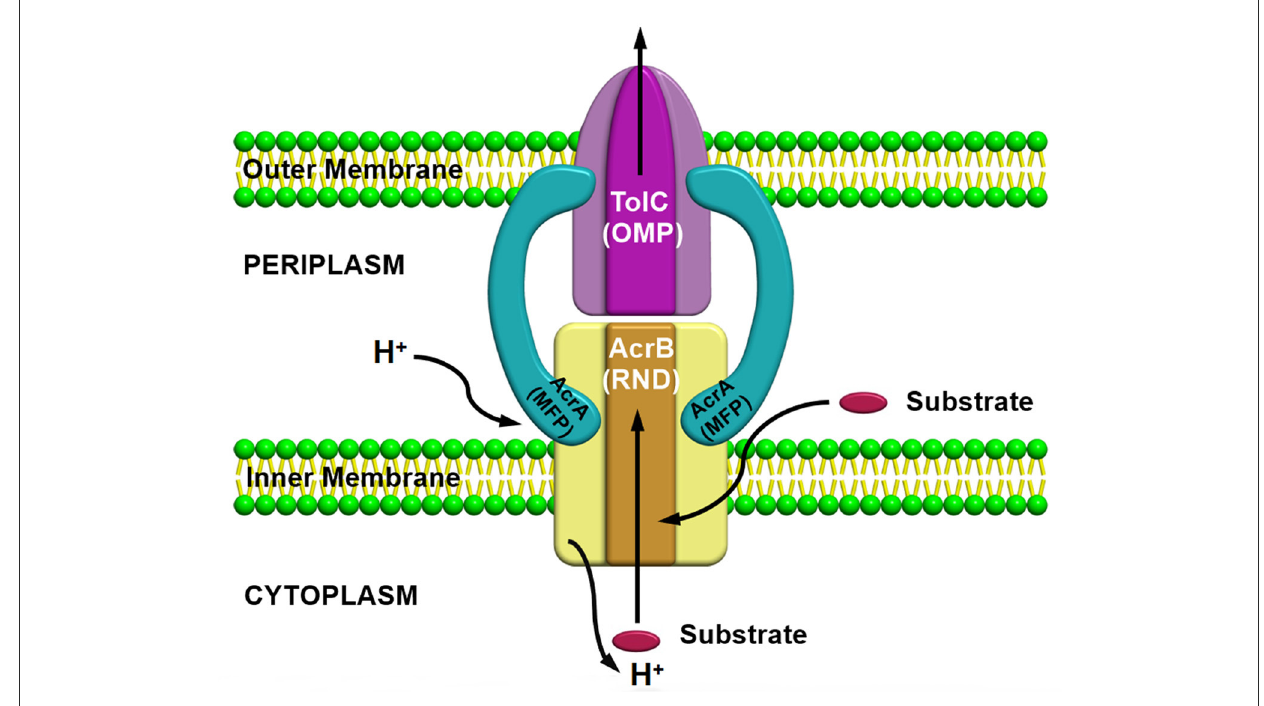
FIGURE3 AcrAB-TolC a tripartite efflux pump system containing three components together to form a